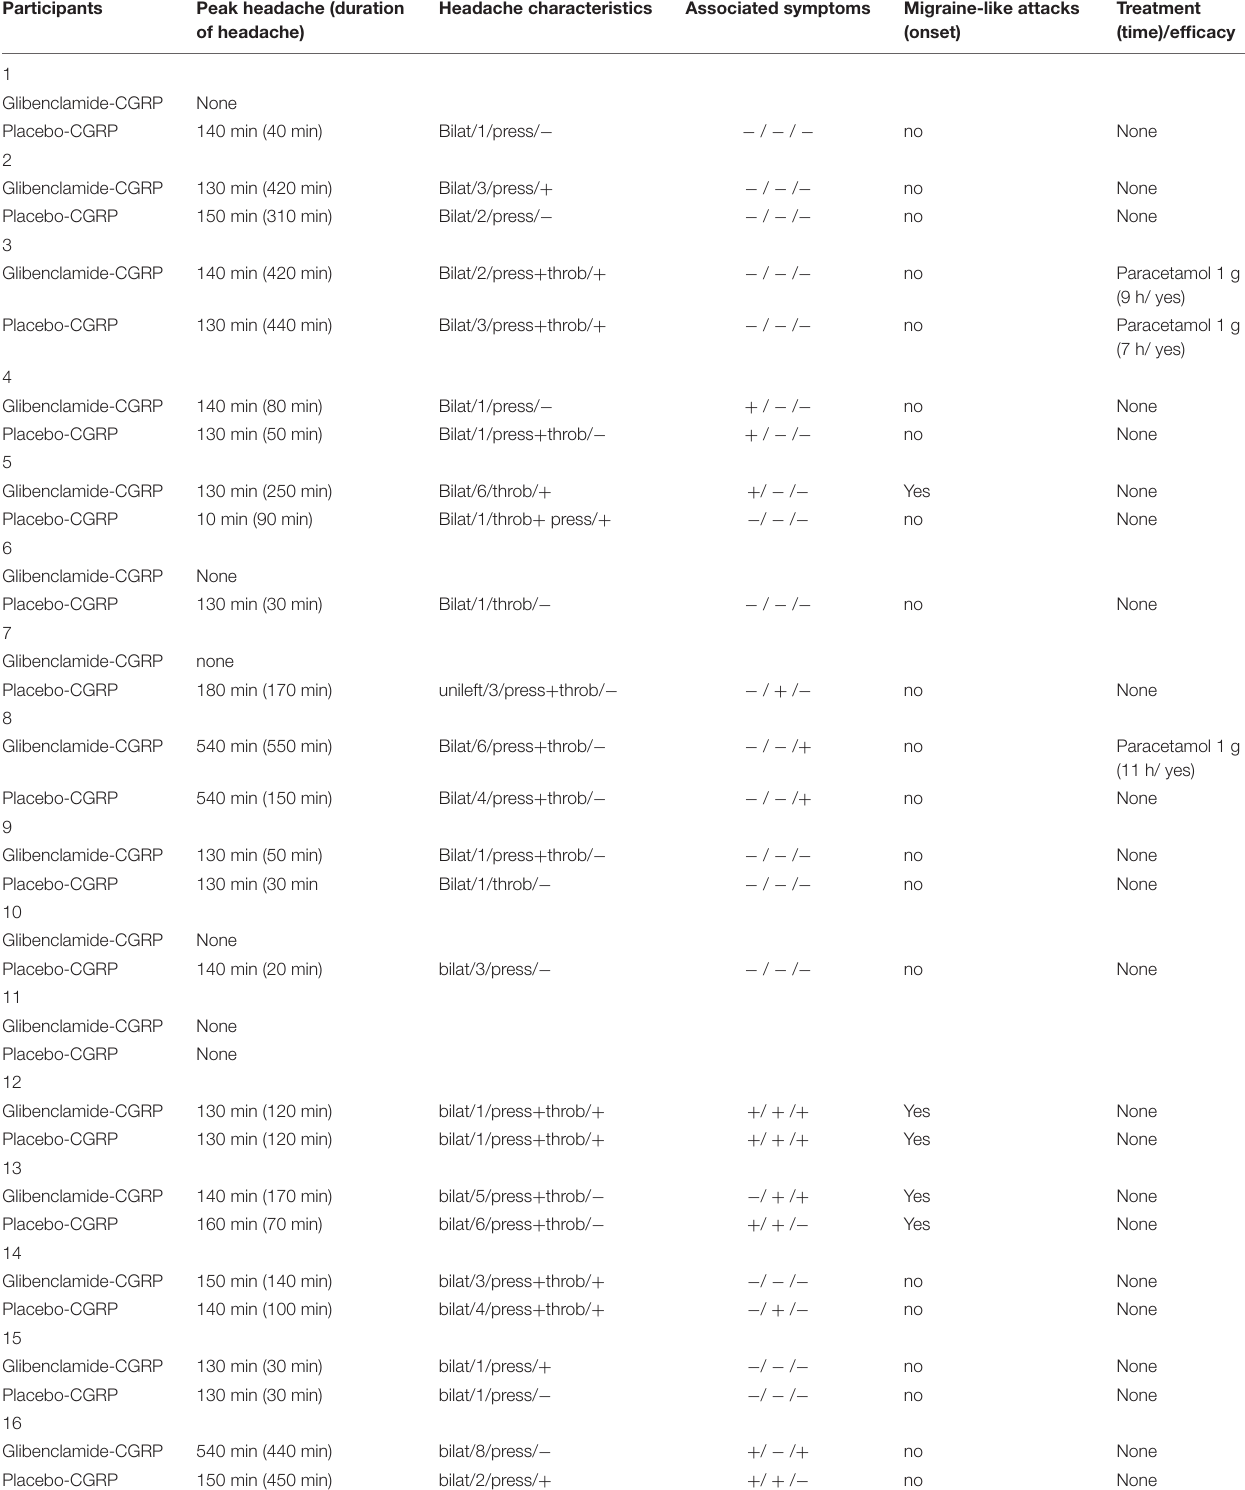
TABLE 1 | Clinical characteristics of headache and associated symptoms in healthy volunteers after glibenclamide and placebo (0–14 h observation period). Participants Peak headache (duration Headache characteristics Associated symptoms Migraine-like attacks of headache)